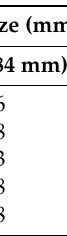
Table 3. Increase in chamfer radius.